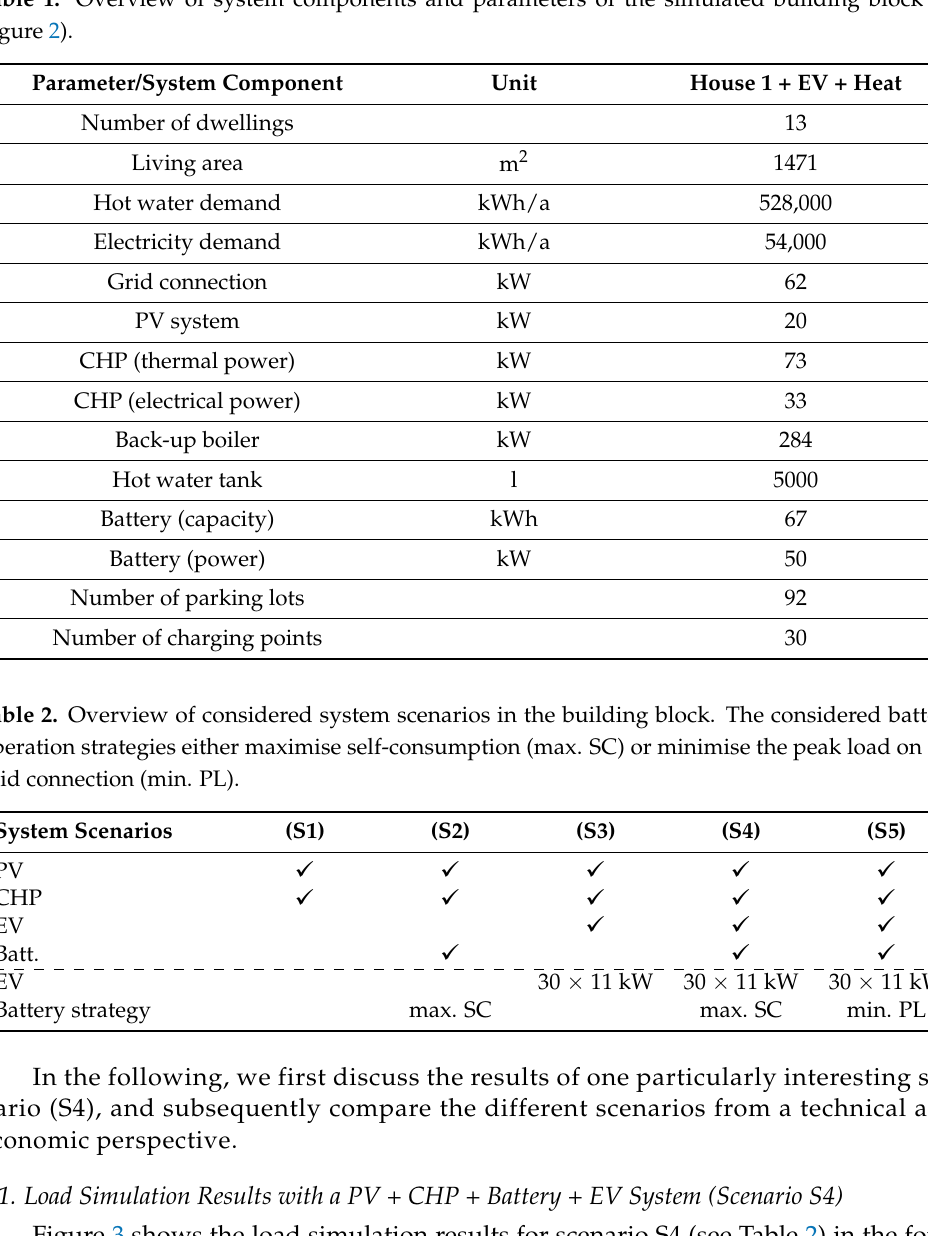
Table 1. Overview of system components and parameters of the simulated building block (cf. Figure 2).